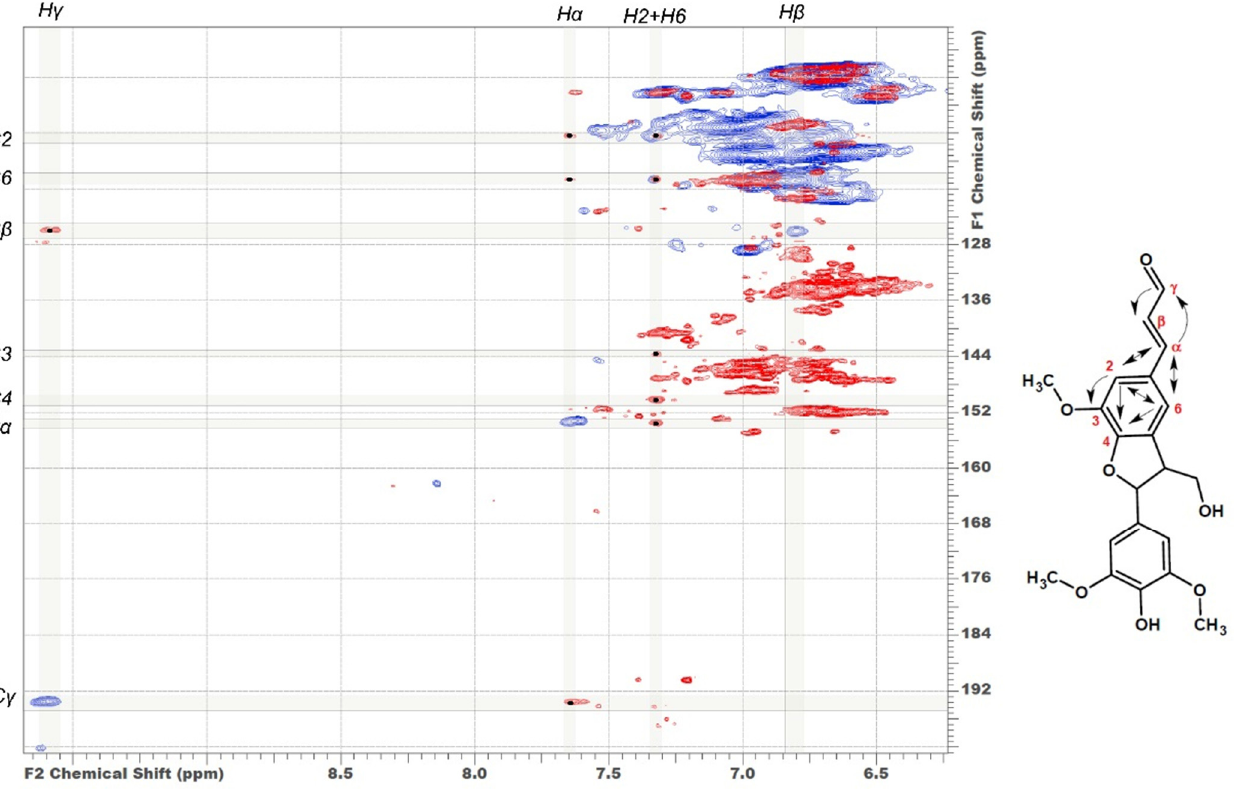
Figure 3. Comparison of HSQC (blue cross-peaks) and HMBC (red cross-peaks) spectra. Correlations used to identify the structure of 5-methoxybalanopholin are shown.